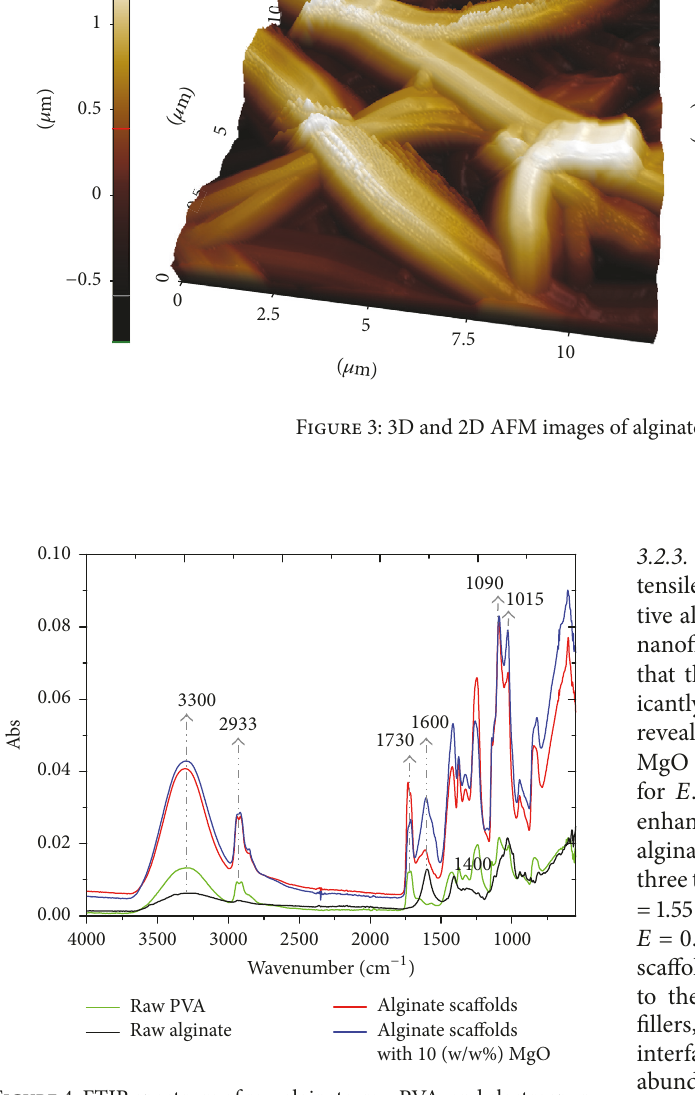
Figure 4: FTIR spectrum of raw alginate, raw PVA, and electrospun alginate-based scaffolds and alginate/MgO